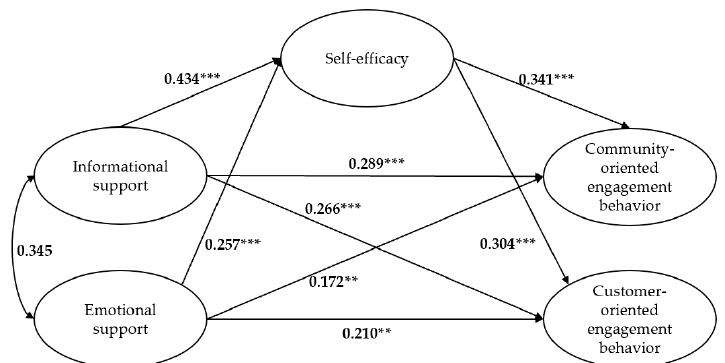
Figure 3. Mediation model of effects of informational support, emotional support, self-efficacy, community-oriented engagement behavior, and customer-oriented engagement behavior. Note: N = 293, *** p < 0.001; ** p < 0.01.